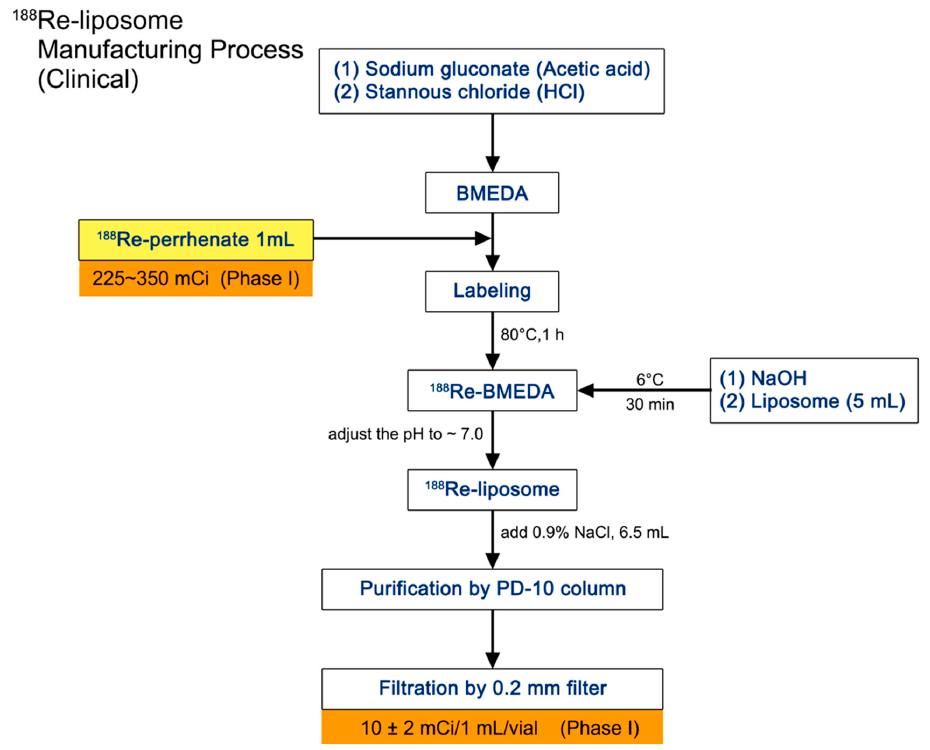
Figure 1. Schematic diagram of preparing 188 Re-liposome. The manufacturing process includes embedment of liposome and 188 Re-perrhenate. The final product would be aliquoted into vials in 10 ± 2 mCi per 1 mL in the phase I trial. BMEDA, N , N -bis(2-mercaptoethyl)- N 9 , N 9 -diethylethylenediamine.